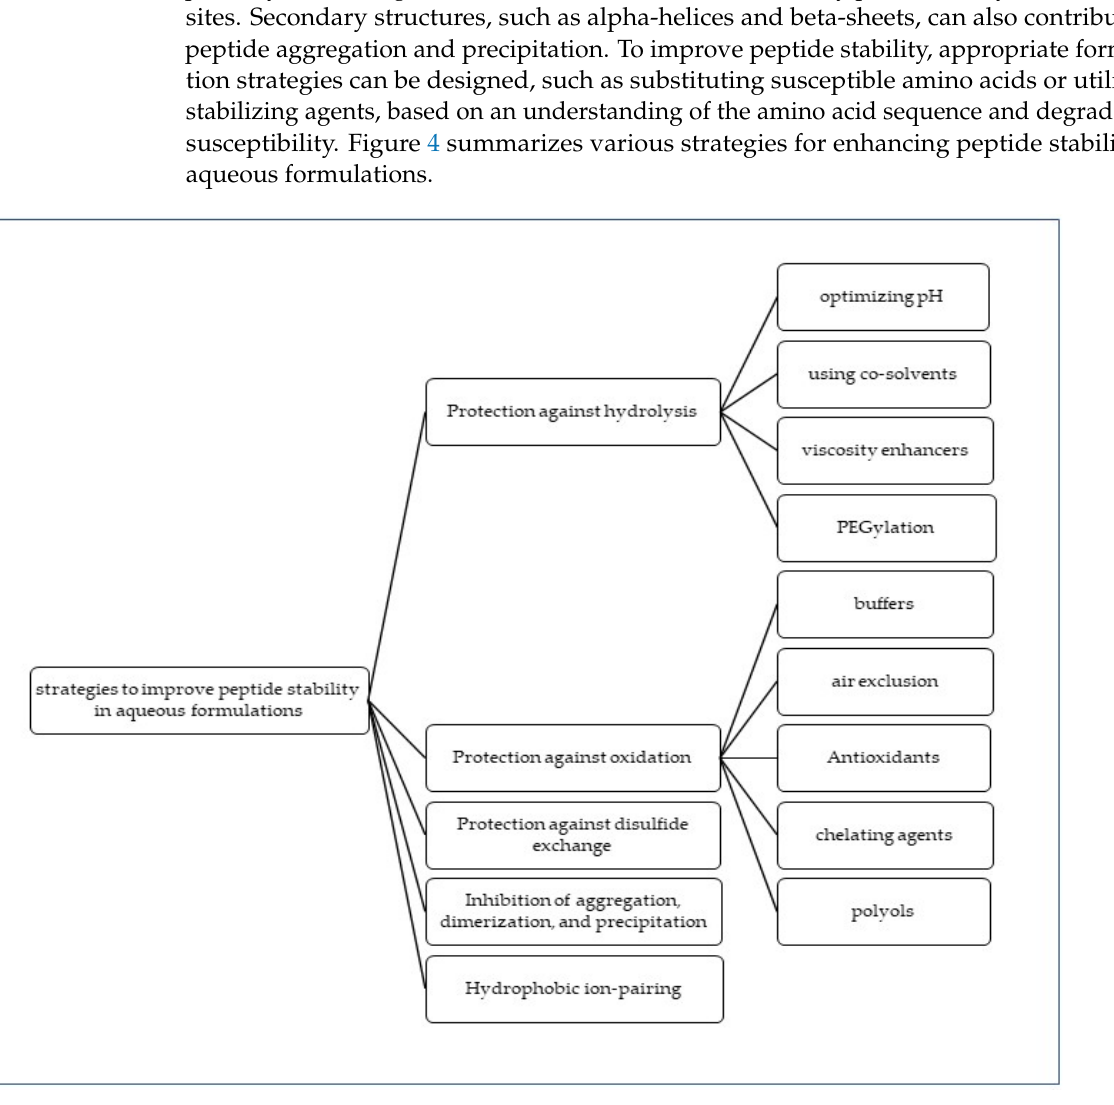
Figure 4. Known strategies that can be used individually or in combination to improve peptide sta ‐ bility in aqueous